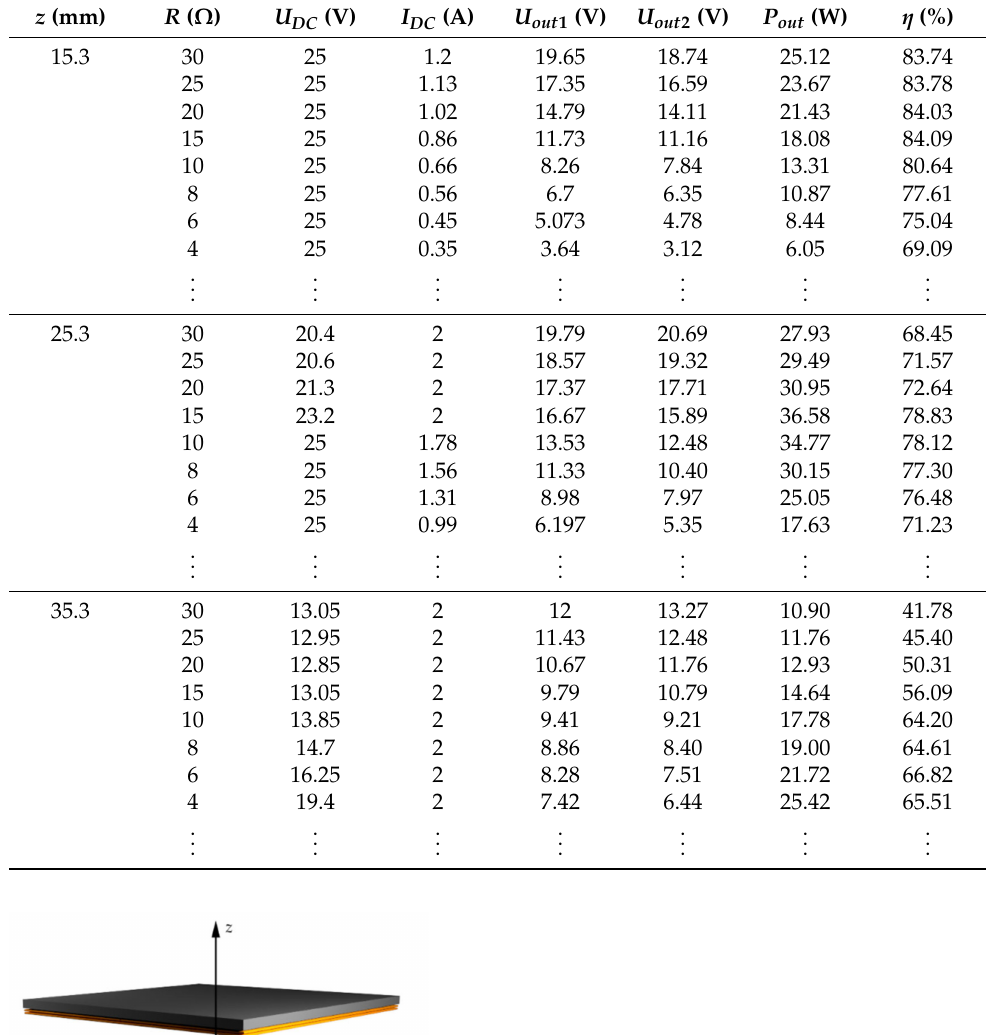
Table 9. Double DD IPT system at different loads.